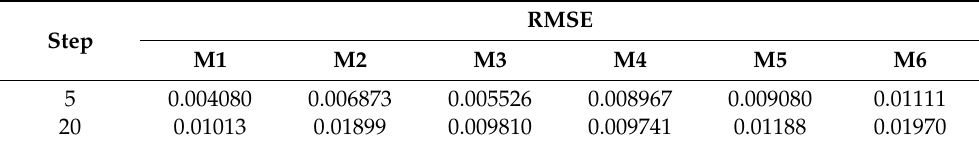
Table 3. Multi-step prediction error analysis